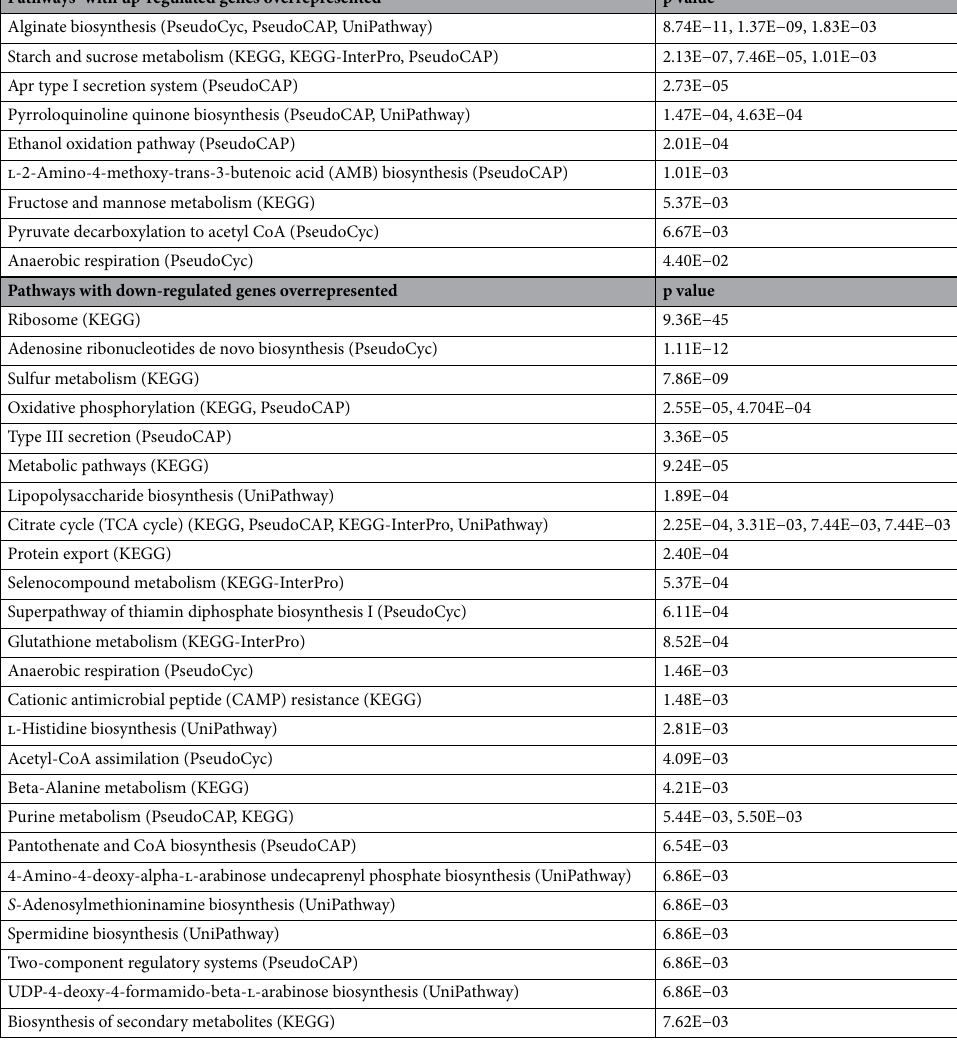
Table 1. Pathways up- and down-regulated from acute (H2&H6) to biofilm infection (D5&D9). **p values for pathways overrepresented with up- and down-regulated genes (Fisher’s exact test implemented in the R package GeneOverlap). a Pathways were downloaded from http:// www. pseud omonas. com/ pathw ays/ list on 2/27/2019 and included KEGG (120), KEGG-InterPro (135), PseudoCAP (126), PseudoCyc (238), and UniPathway (165) pathways—the parentheses in this sentence are numbers of pathways per